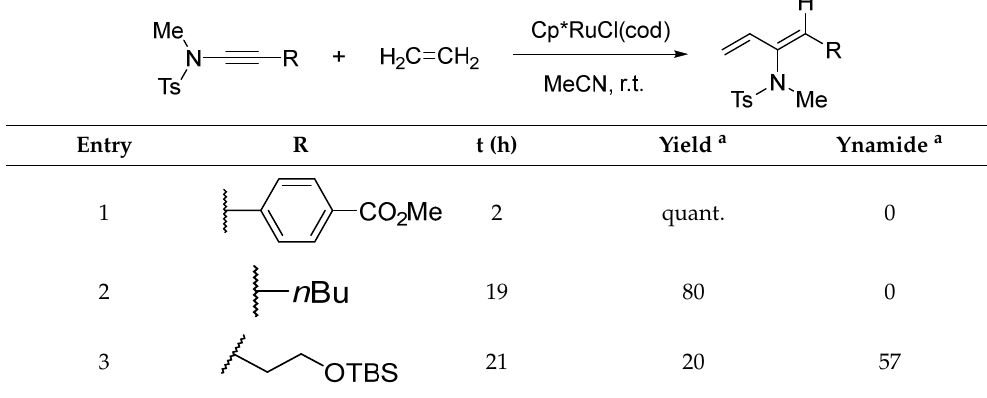
Table 4. Obtaining various dienes substituted by Sato.